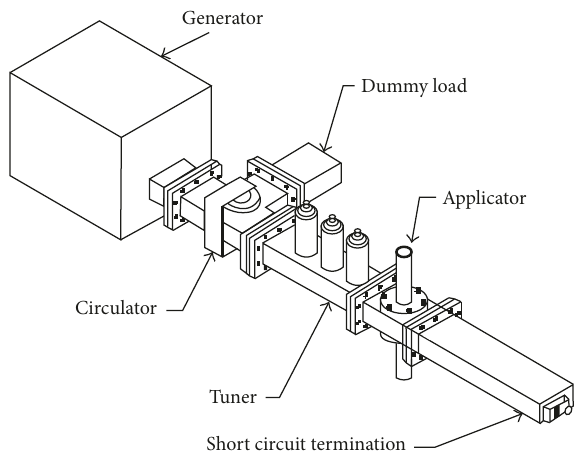
Figure 1: A typical laboratory set-up used for material processing at high temperature in a single-mode microwave